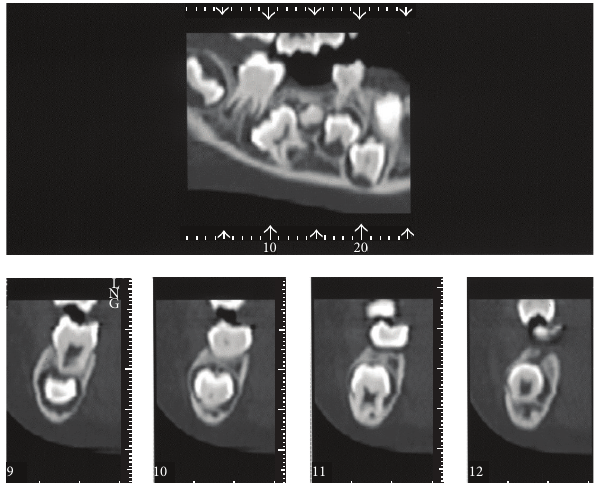
Figure 5: Sagittal reconstruction computed tomography: case 2. The root apex of the impacted primary molar is extremely close to the mandibular canal and mandibular